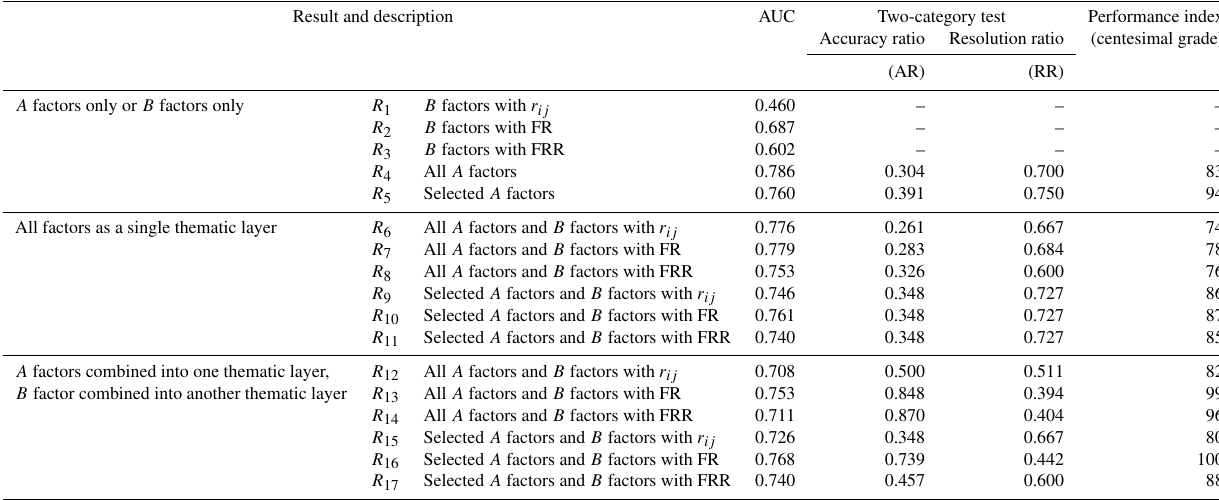
Table 5. Predictive performance of different